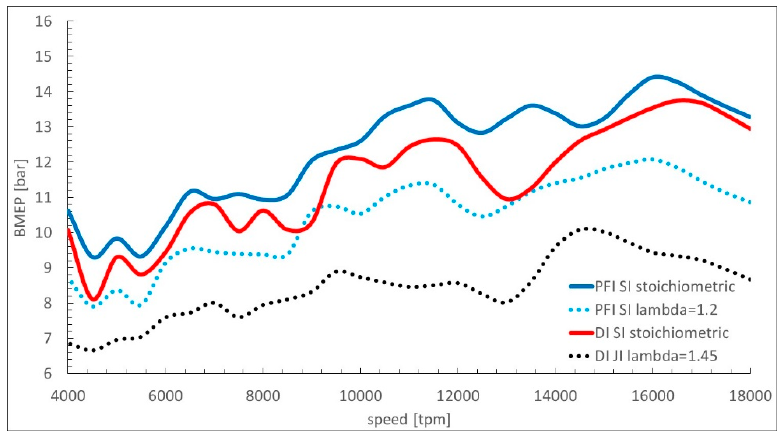
Figure 5. BMEP of engines stoichiometric and lean.